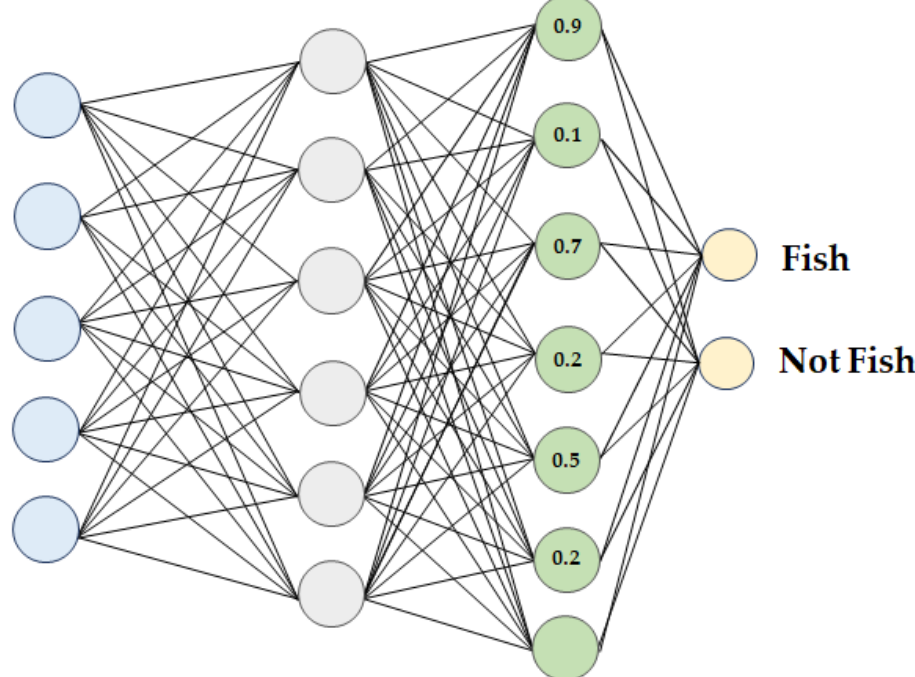
Figure 7. Three types of pooling operations. Three types of pooling algorithms, max pooling, average pooling, and global average pooling, are executed in the pooling layer.